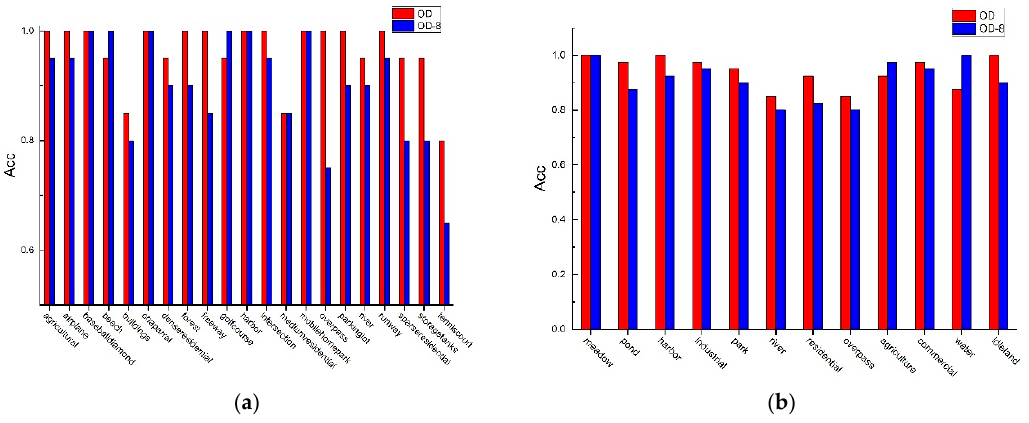
Figure 16. The class accuracy on OD and OD-8. ( a ) UCM dataset; ( b ) Google data of SIRI-WHU.